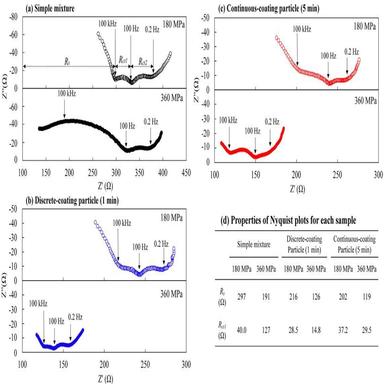
Nyquist plots of the cells prepared with (a) simple mixture, (b) discrete-coating particle, (c) continuous-coating particle, and (d) each resistance component obtained from Nyquist plots.